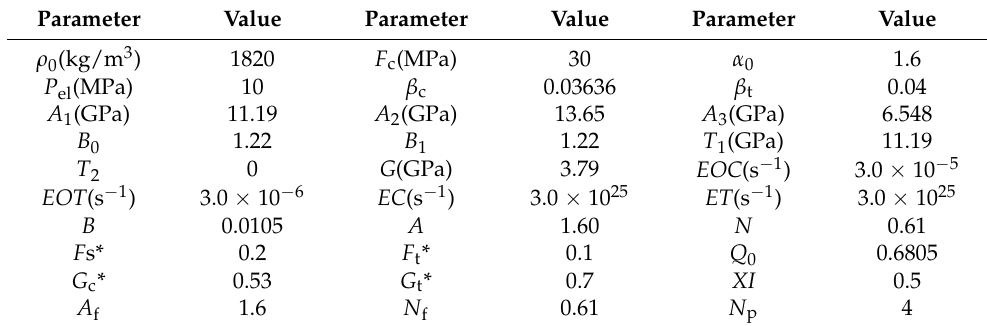
Table 1. The parameters of RHT model for coal mass. F s, F t , G c , G t represent relative shear strength, relative tensile strength, compressive yield surface parameter, tensile yield surface parameter.